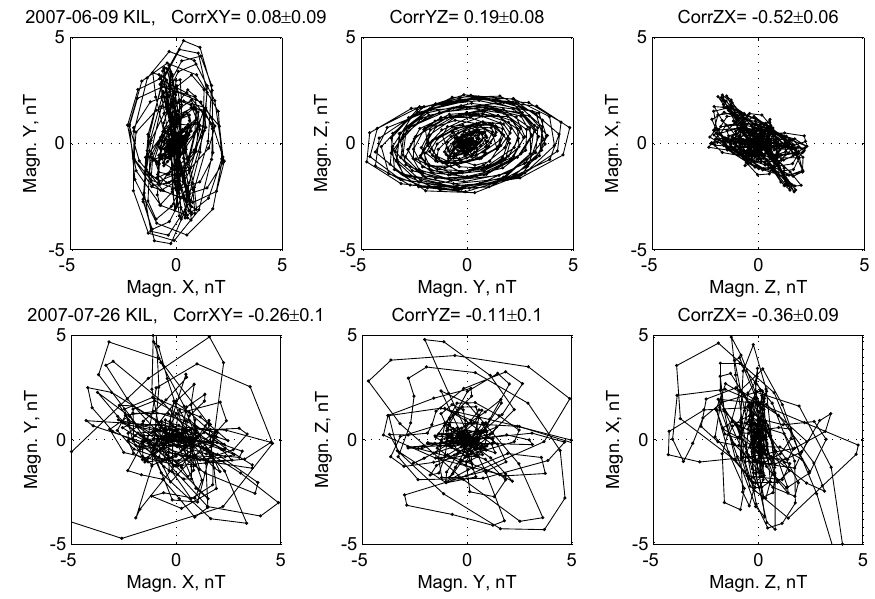
Fig. 10. Hodographs of geomagnetic pulsations Pc4 (top panels) and Pi2 (bottom panels) in XY , YZ , and ZX planes. Correlation coefficients between the components are indicated on tops of the